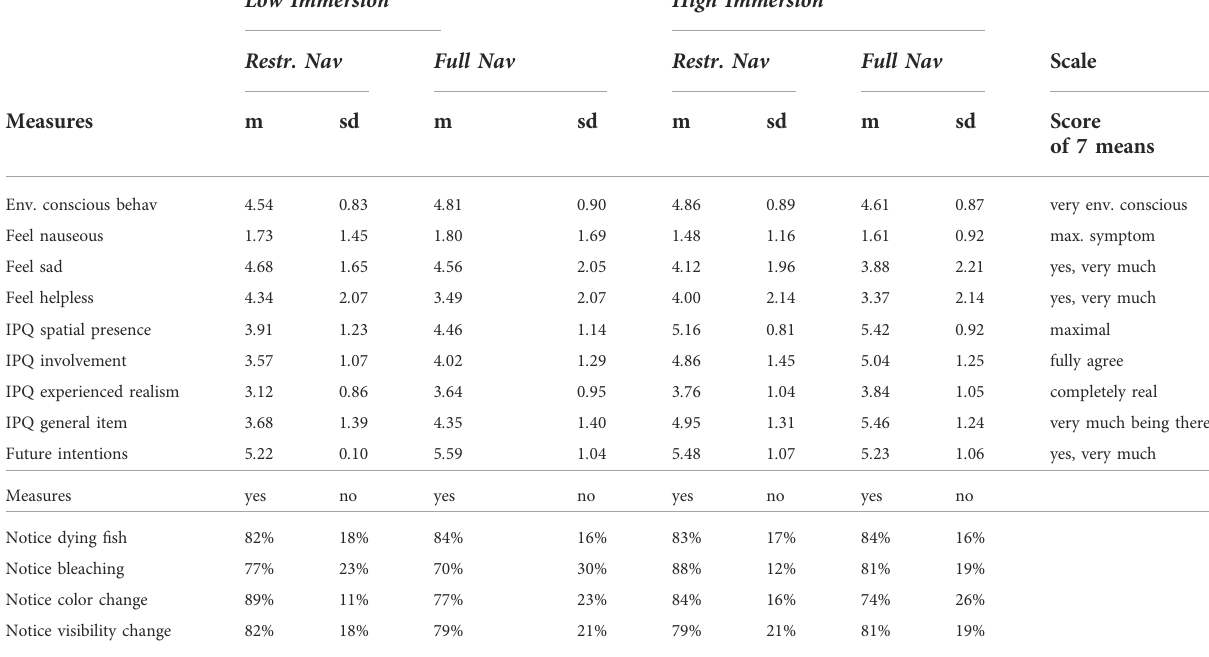
TABLE 2 Means and standard deviations of the questionnaire items, together with the scales, or percentages in the case of the yes/no questions. Low Immersion High Immersion Restr. Nav Full Nav Restr. Nav